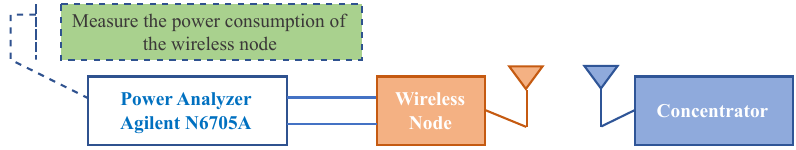
Figure 10. Power consumption test